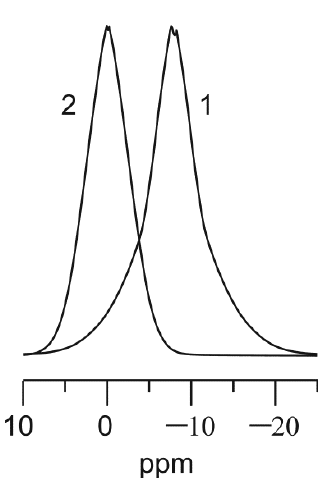
Figure 1. Single-pulse 31 P-MAS NMR spectra of powder samples of TiHP ( 1 ), and Na-TiHP ( 2 ).